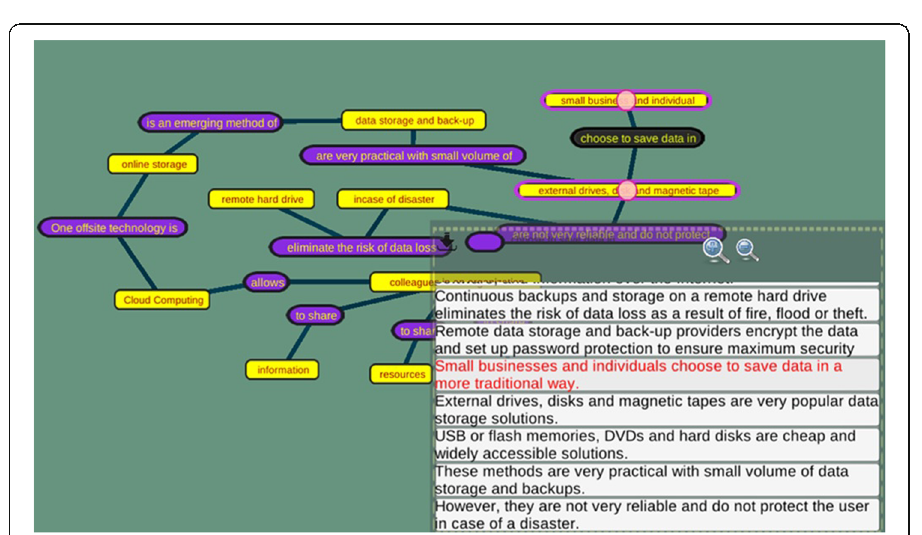
Fig. 2 Example of kit-build with the source